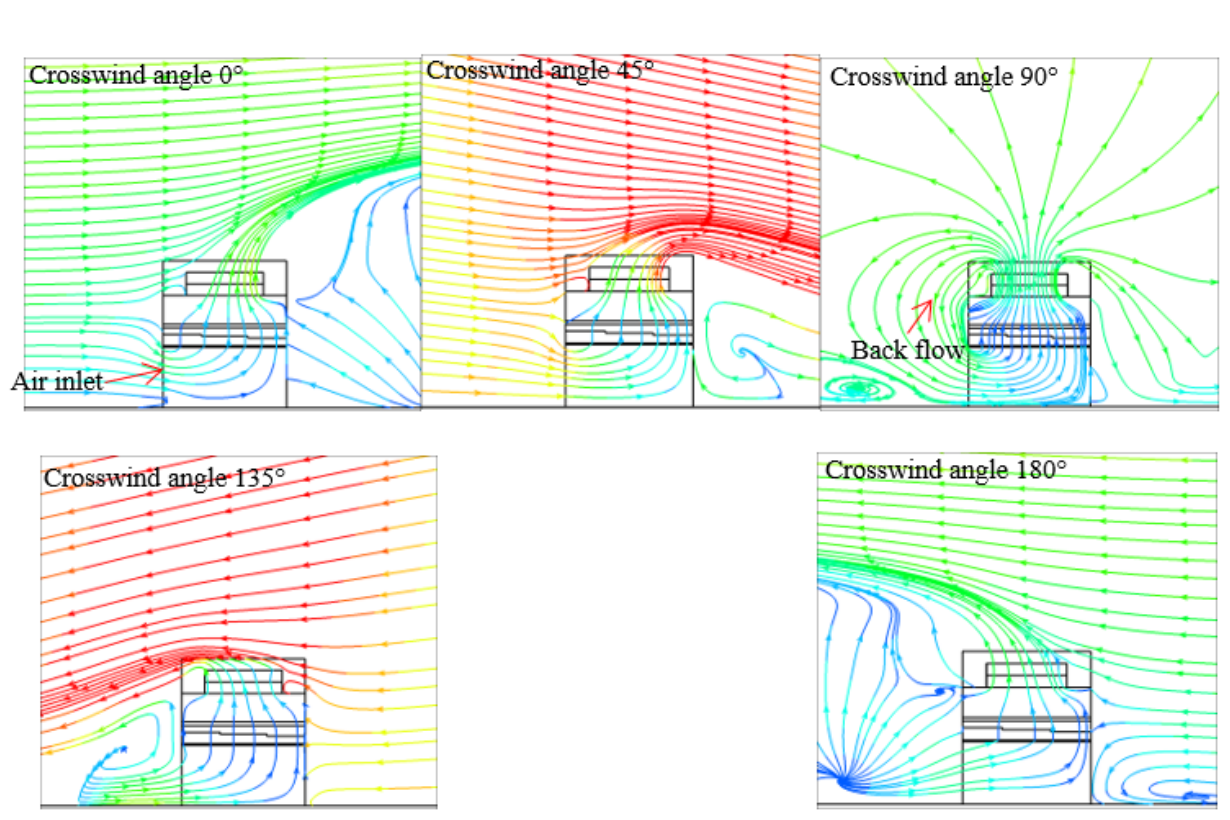
Figure 9. The streamlines around the tower at the plane xz.